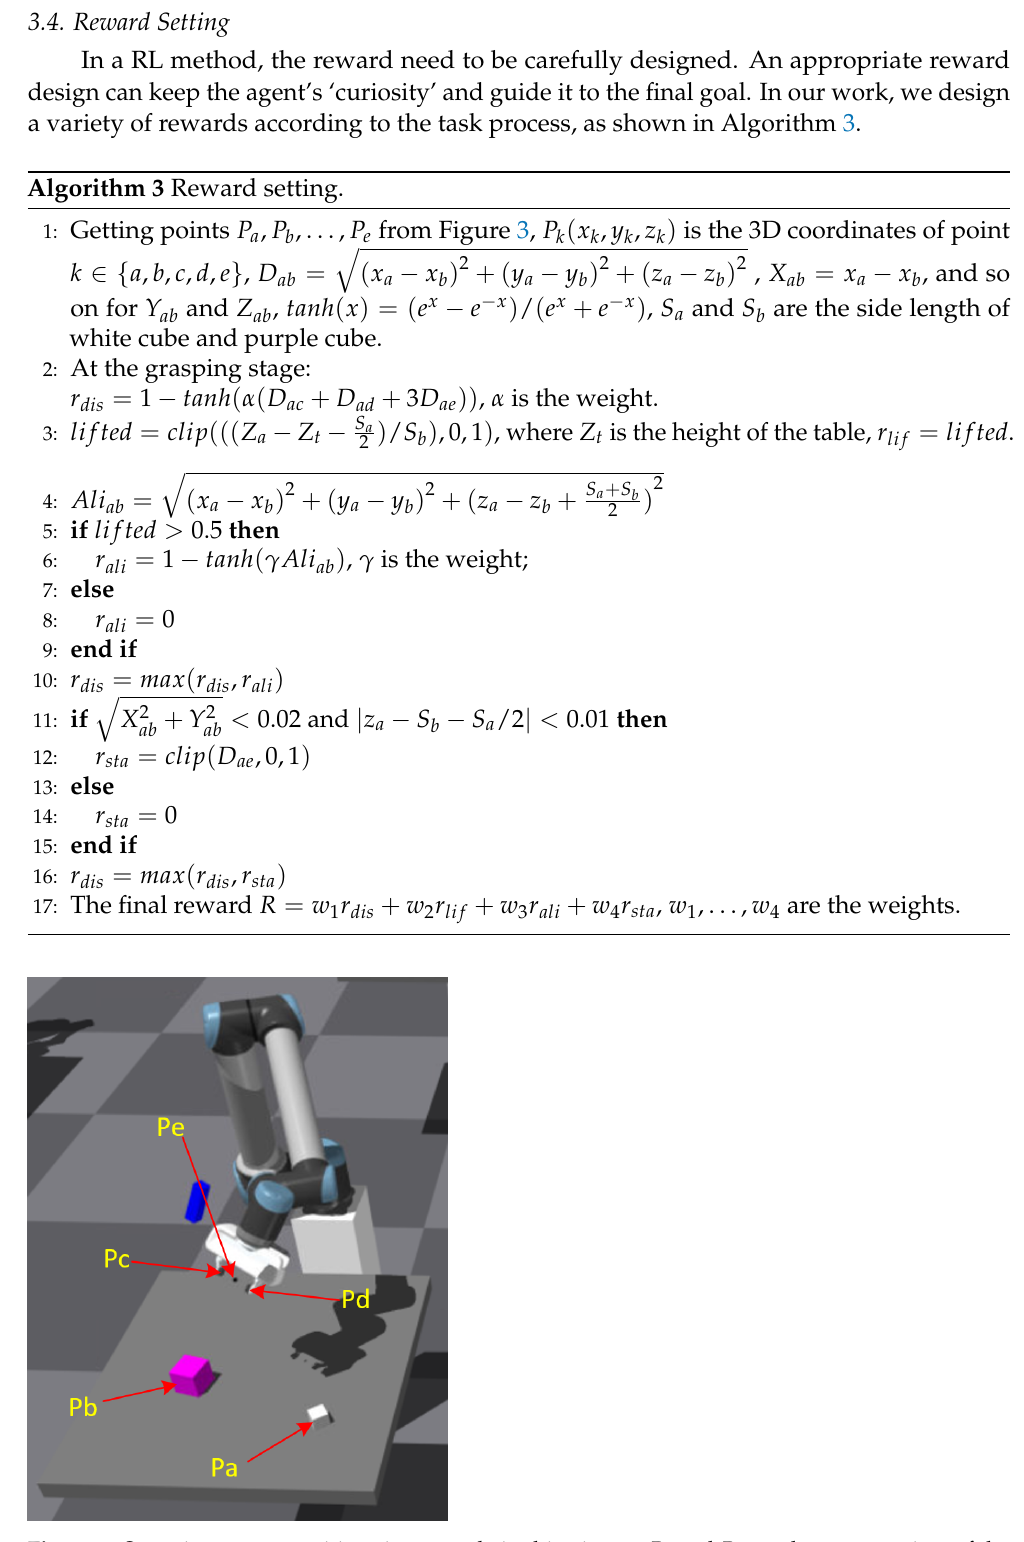
Figure 3. Some important positions in our task, in this picture, P a and P b are the center points of the two cubes, P c and P d are the tips of two fingers and P e is the